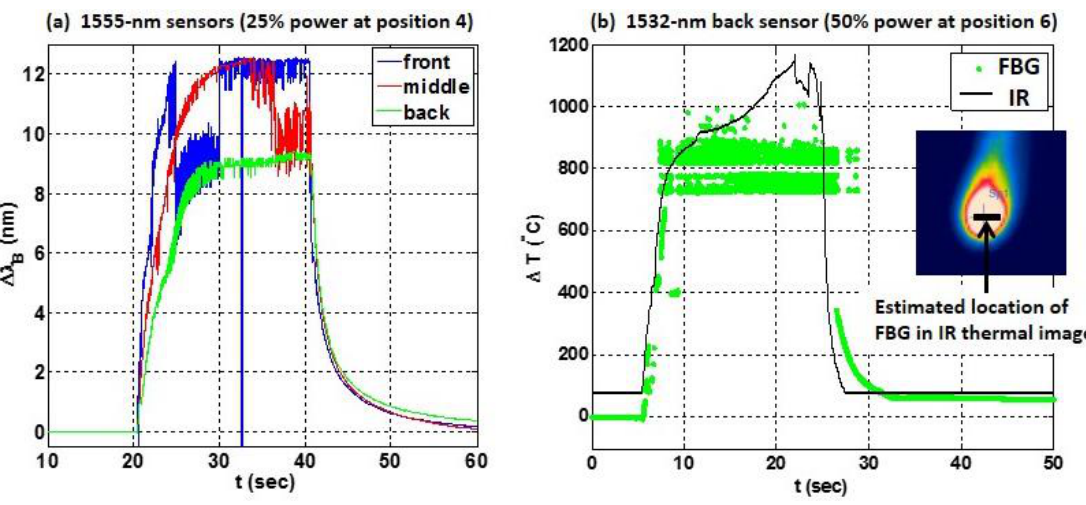
Figure 13. ( a ) Wavelength shift during a direct strike at position 4 in the front (blue), middle (red) and back (green) 1555-nm sensors (as shown in Figure 9); ( b ) Temperature on the back surface of the composite during a direct strike at position 6, estimated using the wavelength shift of the back 1532-nm sensor (green dots) or measured with an IR camera calibrated for higher temperatures (black).